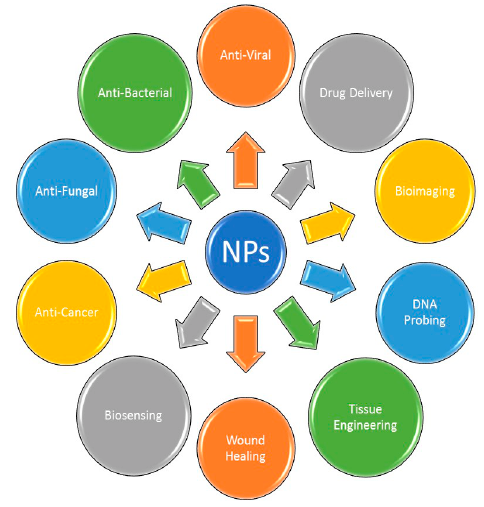
Figure 3. Major applications of metallic NPs.